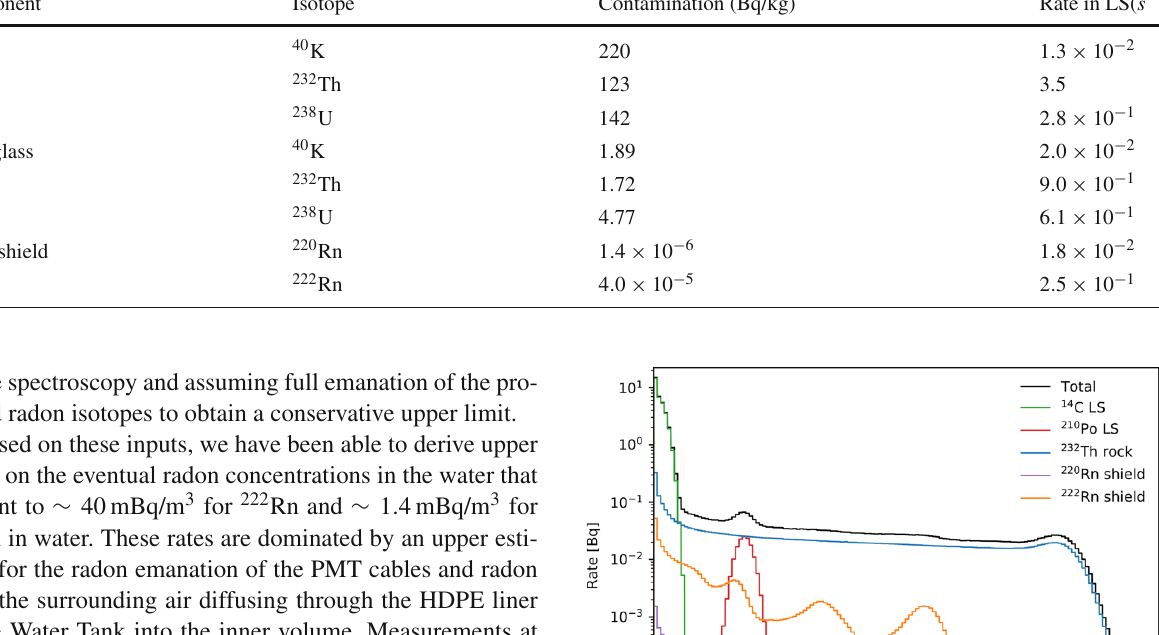
Table 4 The main contributors to the single-event background in OSIRIS. The external background from γ -emission in the surrounding rock and from PMT glass are dominating compared to a potential radon contamination of the water shield (based on [14]) Component